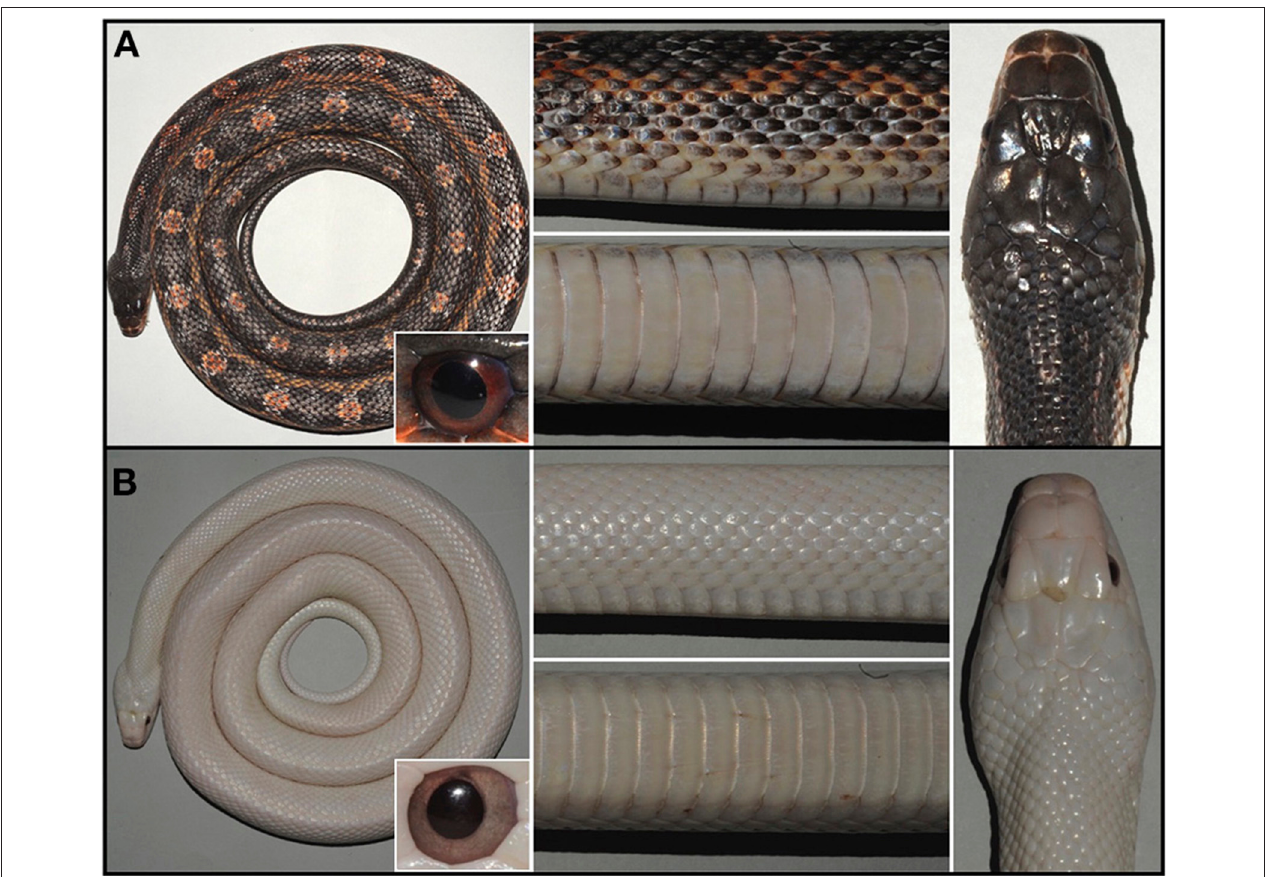
FIGURE 1 | Coloration of wild type (A) and leucistic (B) Texas rat snakes. A dorsal overview (left), close ups of lateral and ventral views (center), and a head dorsal view are provided. The inset shows the iris